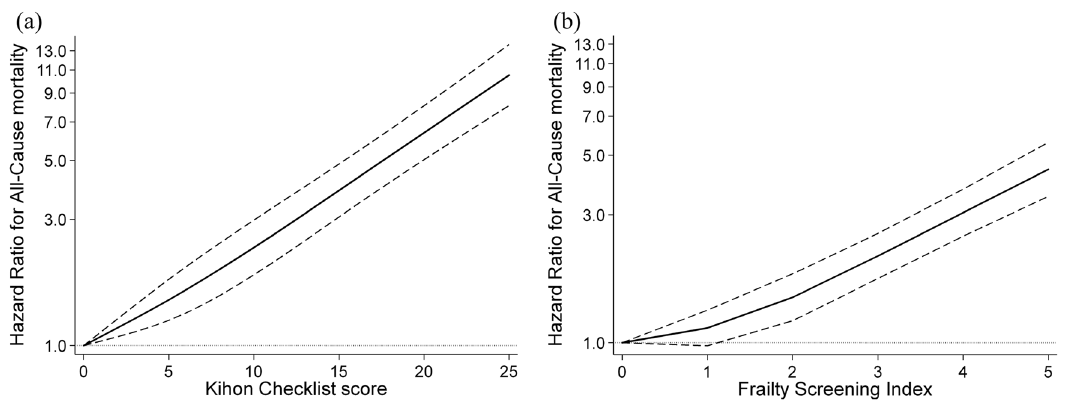
Figure 3. Restricted cubic spline regression model between KCL ( a ) and FSI ( b ) score and risk of all-cause mortality. The Kihon Checklist (KCL) and Frailty Screening Index (FSI) received a point by every problem with activity or function, and the higher the total score, the greater the difficulty in daily functioning (high frailty). Solid lines represent hazard ratios, and dashed lines represent 95% confidence intervals (CI), and the hazard ratio based on 0 point of both KCL and FSI as reference was calculated. We estimated that p < 0.05 when the 95% CI of the hazard ratio exceeded 1.00, and p ≥ 0.05 when the 95% CI of the hazard ratio did not exceed 1.00. The adjustment factors are age, sex, population density, family structure, economic status, educational attainment, smoking status, alcohol consumption status, sleep time, medication use, and number of chronic